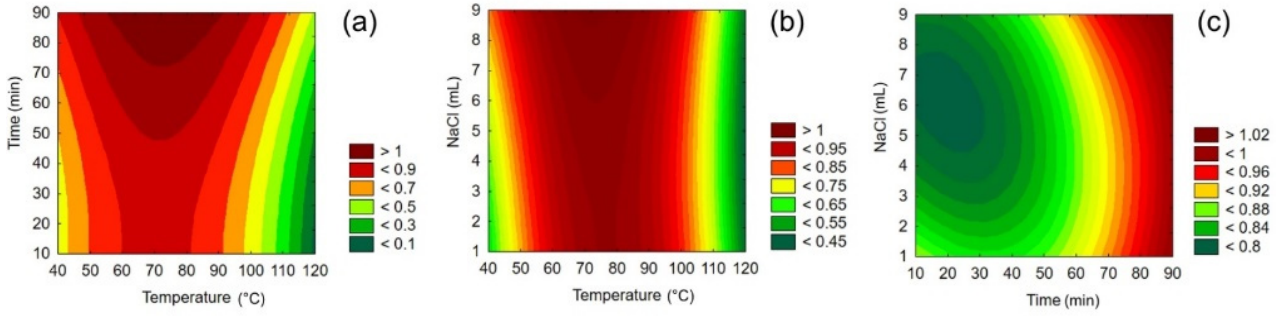
Figure 1. Suitability of the extraction conditions as a function of ( a ) extraction temperature and extraction time, ( b ) extraction temperature and volume of NaCl solution, and ( c ) extraction time and volume of NaCl solution determined by the response surface method evaluation of central composite design of extraction.